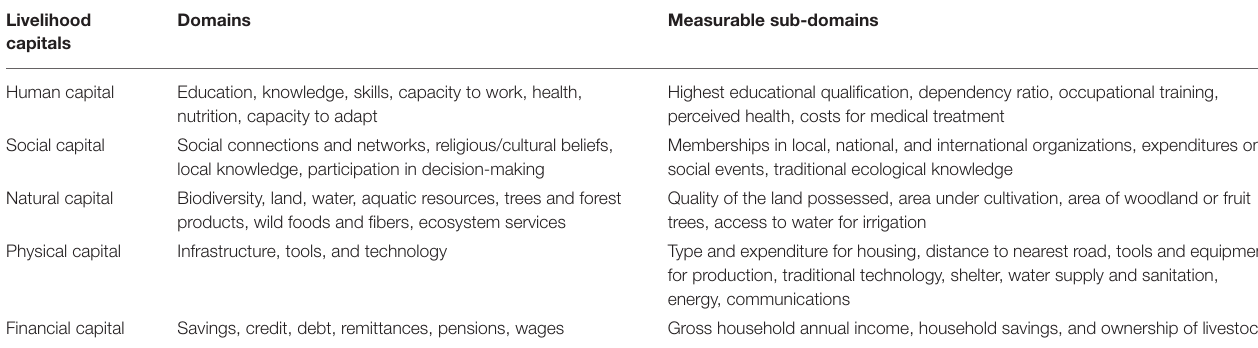
TABLE 1 | “Ingredients” for consideration: livelihood capitals, domains, and sub-domains. Livelihood capitals